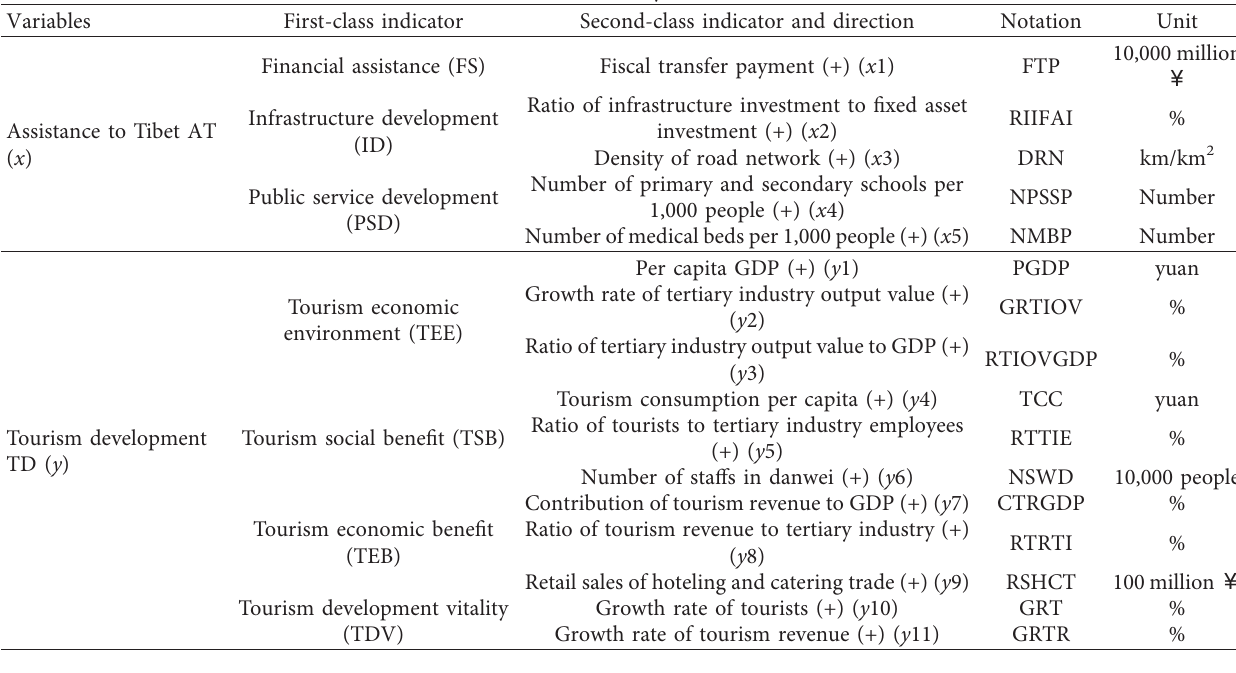
Table 2: Evaluation grade of T of AT and TD. Value T <